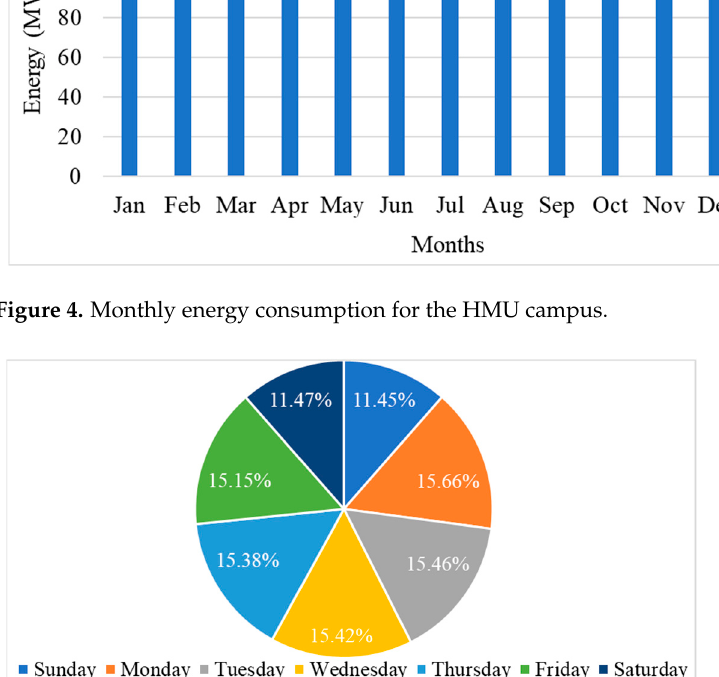
Figure 4. Monthly energy consumption for the HMU campus.